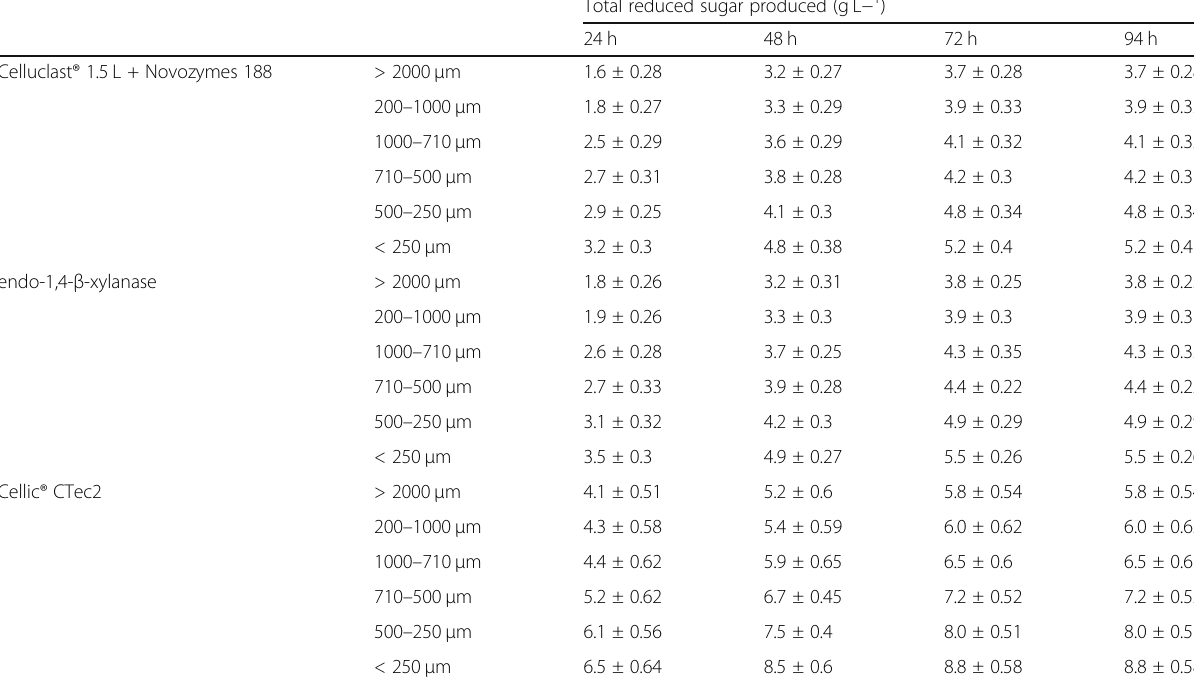
Table 2 Influence of different particle size on total reduced sugar yield (g L − 1 ) at pH